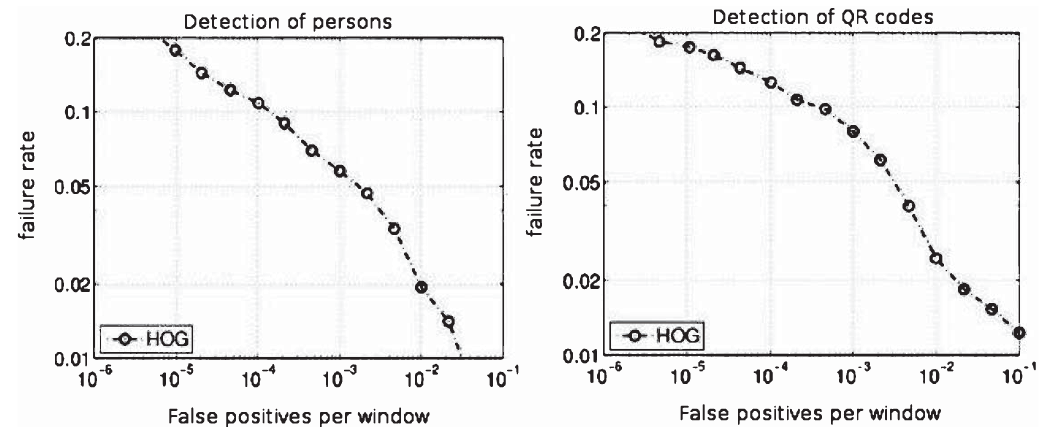
Fig. 12. Performance of the SVM detection of persons and the QR-images.